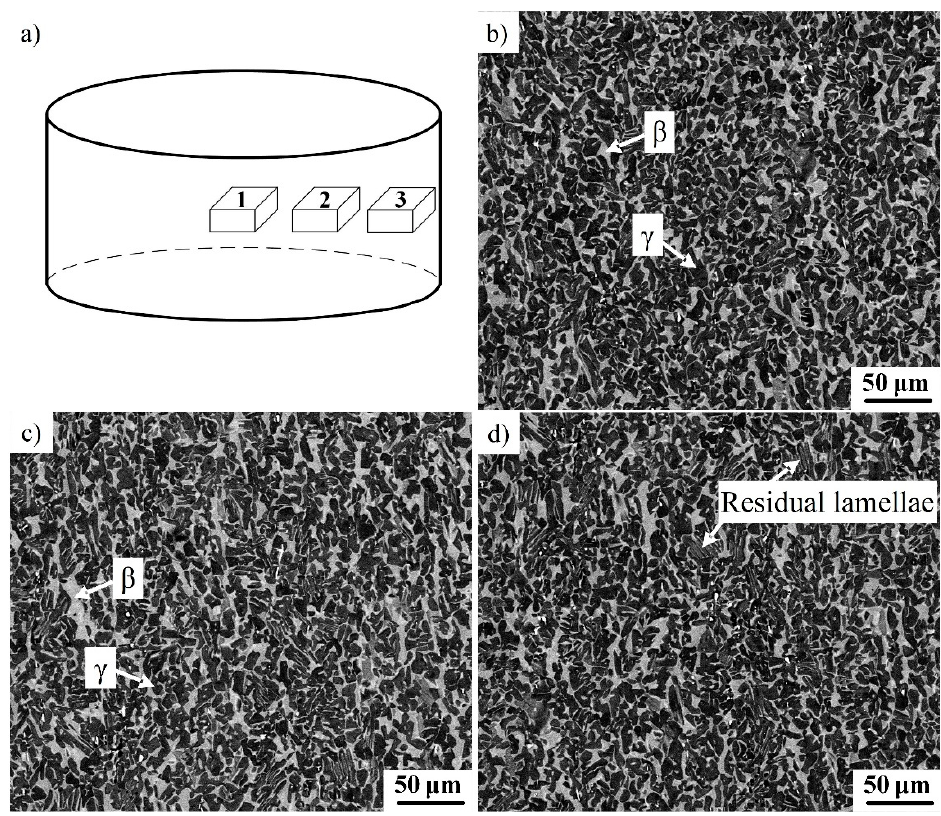
Figure 3. The microstructural characterization of the Ti–43Al–2Cr–0.7Mo–0.1Y billet. ( a ) Sampling position; ( b ) position 1; ( c ) position 2; and ( d ) position 3.